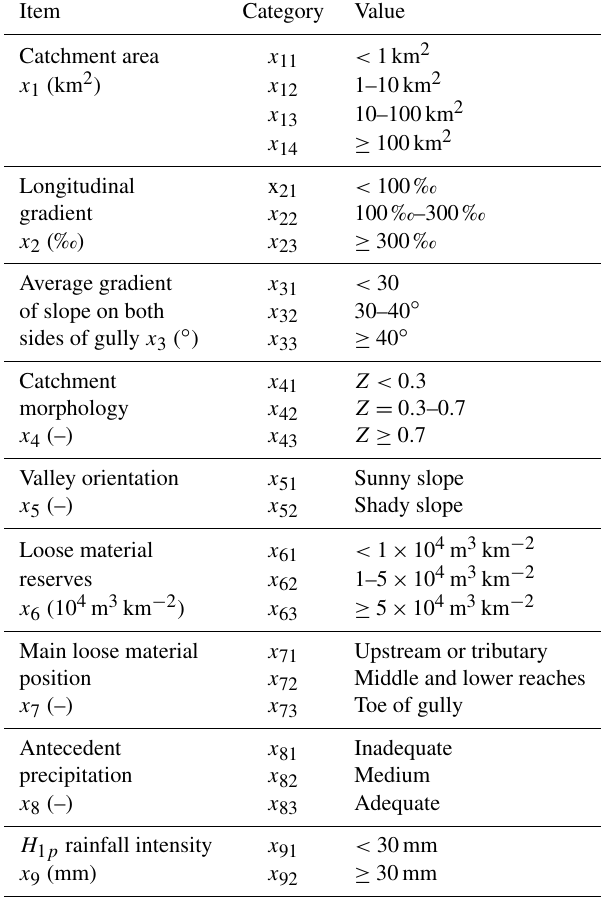
Table 6. Score values of each index after normalization.